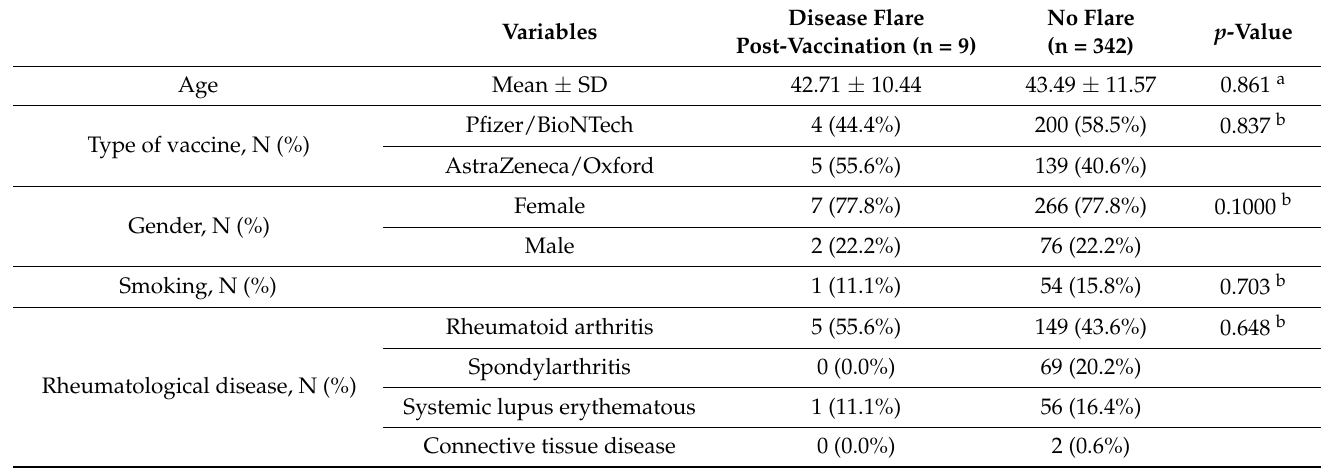
Table 3. Flares post-vaccination (n = 351).